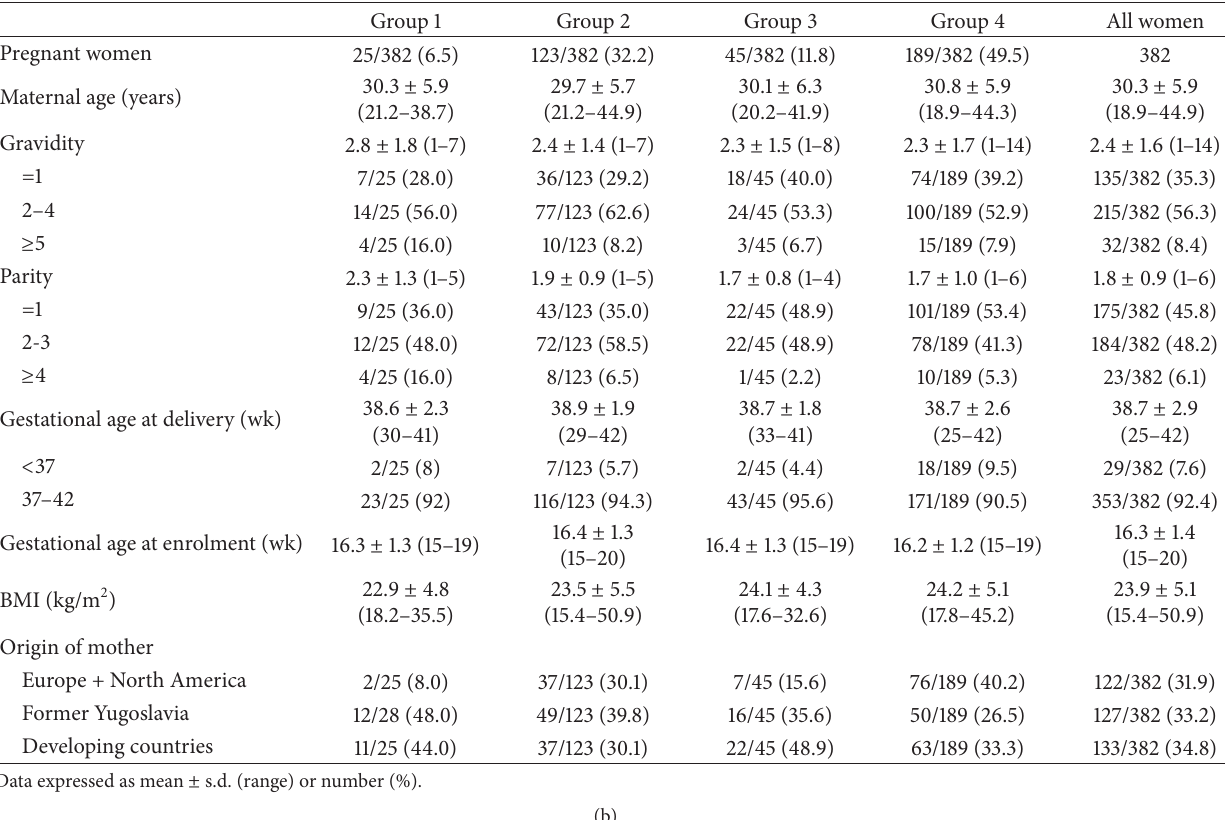
Table 1: Demographic and clinical